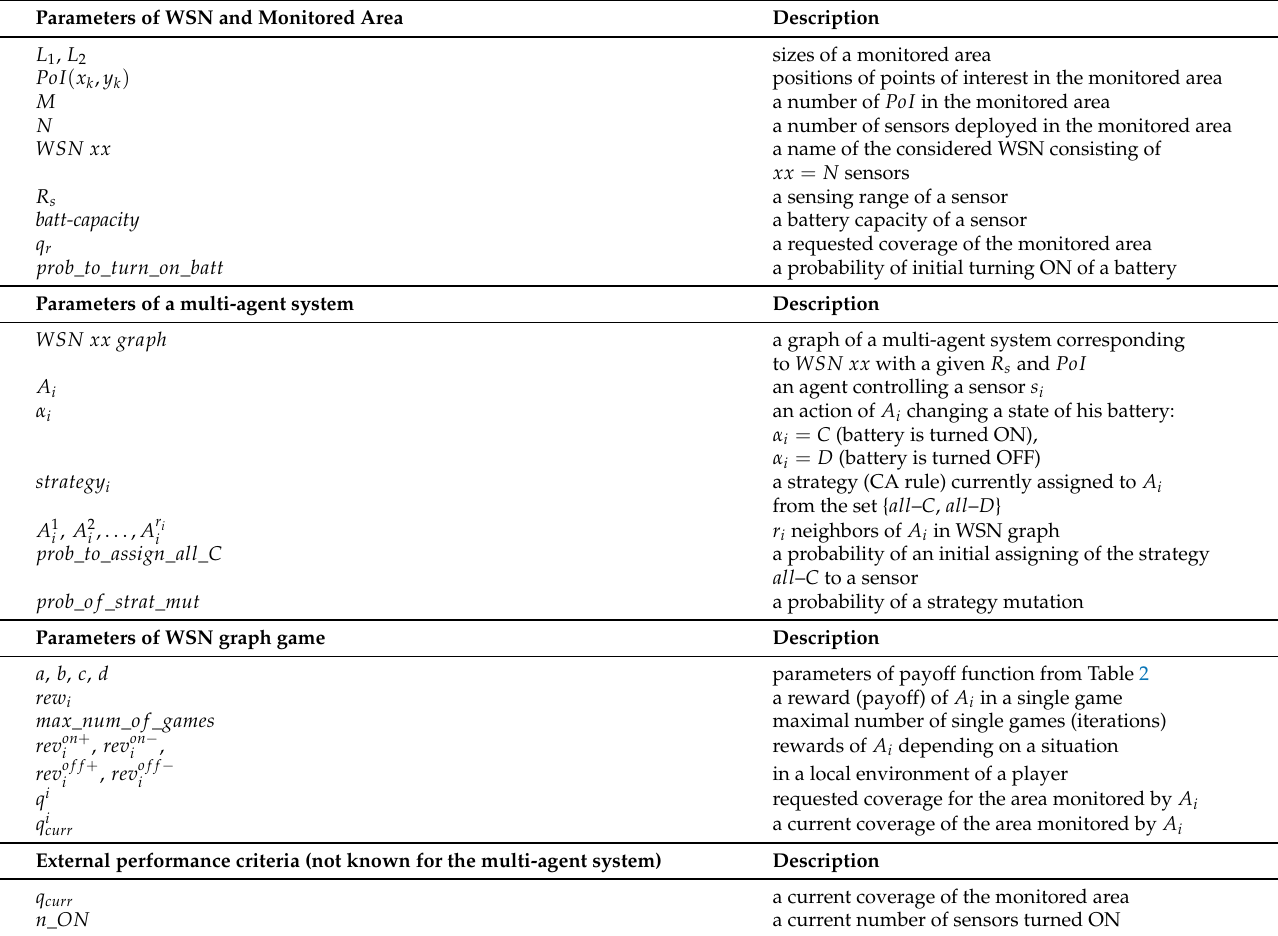
Table 3. Parameters of Competitive Co-evolutionary CA-based system for self-optimization of